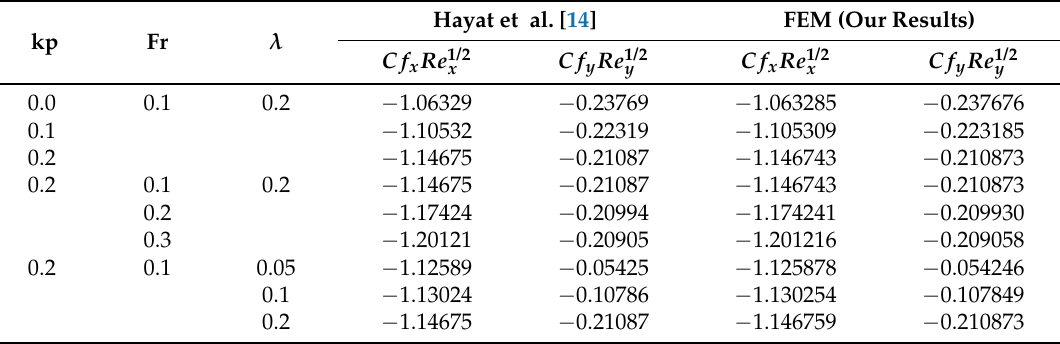
Table 1. Comparison of skin friction coefficients for different values of kp, Fr, and λ when M = We = 0, β → ∞ at ξ =